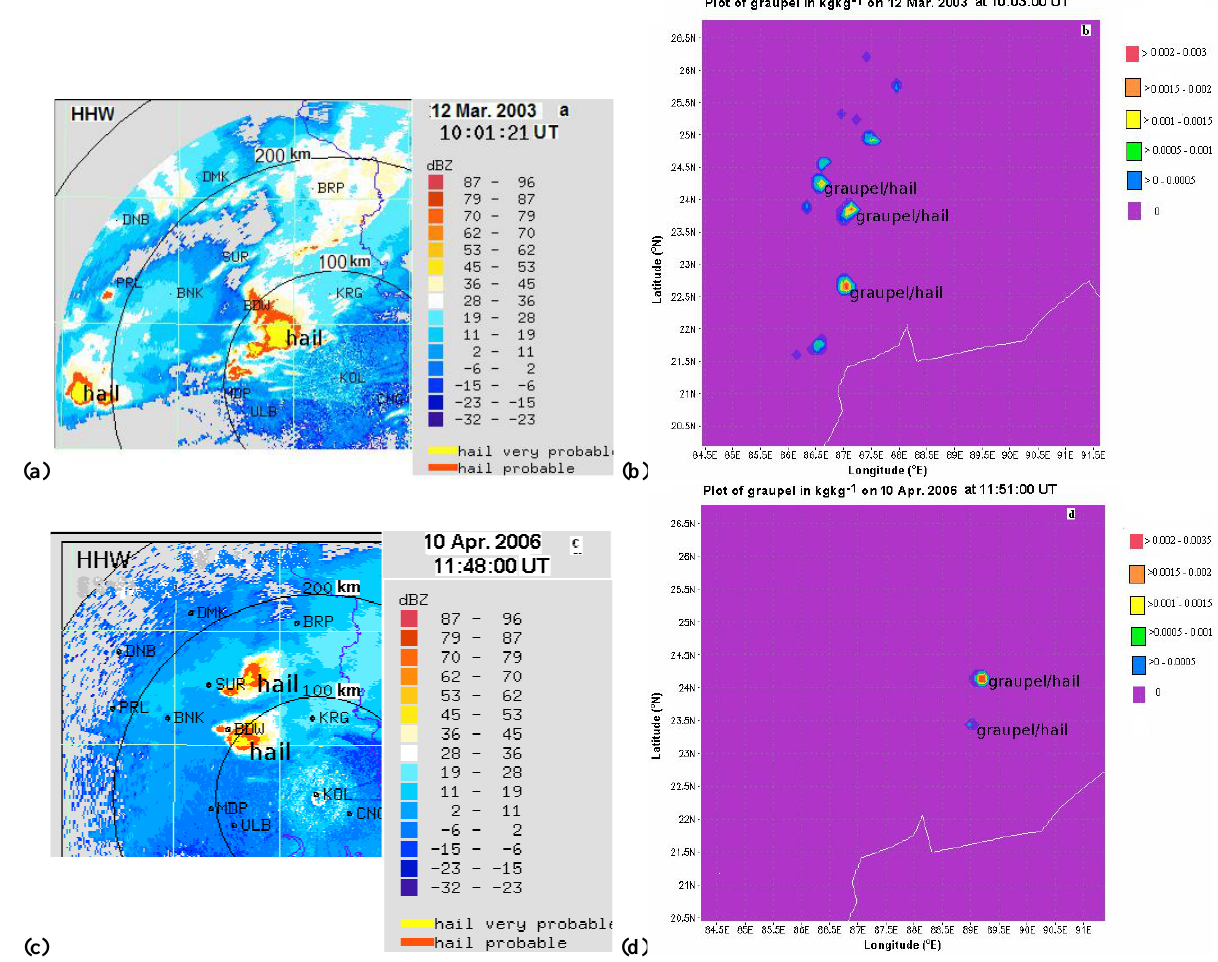
Fig. 7. (a) DWR derived hail warning product HHW at 10:01UT, 12 March 2003. (b) Model simulated graupel with modified cloud microphysics at 10:03UT, 12 March 2003. (c) DWR derived hail warning product HHW at 11:48UT, 10 April 2006. (d) Model simulated graupel with modified cloud microphysics at 11:51UT, 10 April